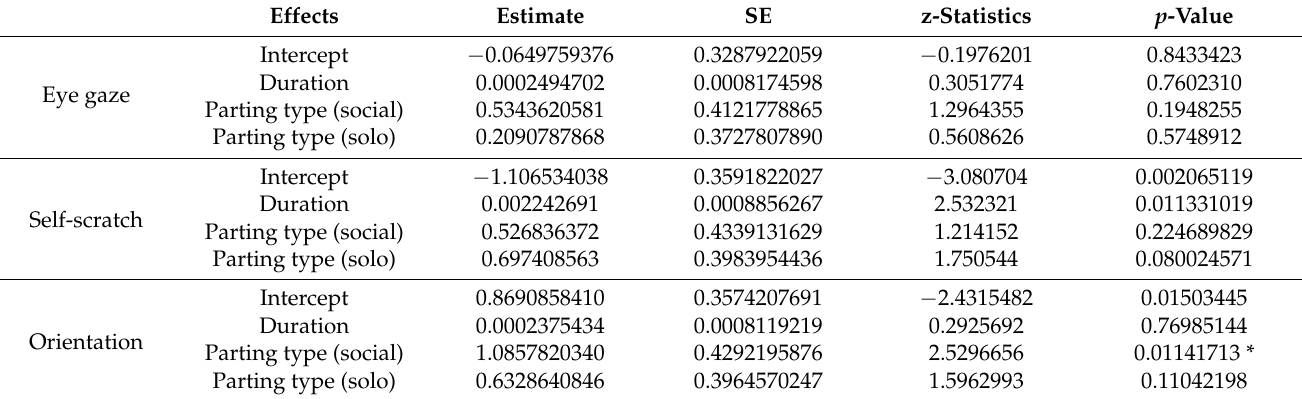
Table 4. Regression parameter estimates for joint binary model.